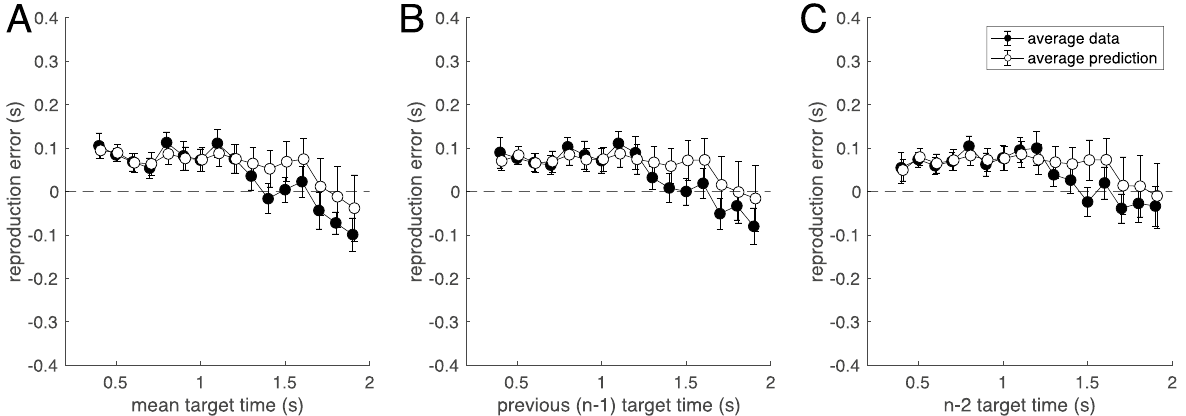
Figure 9. Average data for the ‘random walk’ condition of the duration reproduction experiment (black dots), in which successive stimuli were similar, presented together with averaged model predictions (not fits) of the iterative two-state models used in Fig. 5 (open dots). Stimuli are the same as in Fig. 5 except for the order of presentation. Model parameters were determined from fitting the ‘randomized’ condition and are the same as used in Fig. 5. ( A ) Reproduction error as a function of the current target duration (R 2 = 0.629). ( B ) Reproduction error as a function of the previous target duration (R 2 = 0.544). ( C ) Reproduction error as a function of the target duration two trial in the past (R 2 = 0.428). Data points are averages of 7 to 14 subjects (only 7 subjects received long durations above 1.7 s); error bars denote SEM. Average model predictions are calculated from trial-by-trial predicted individual time courses using the parameters corresponding to Fig.